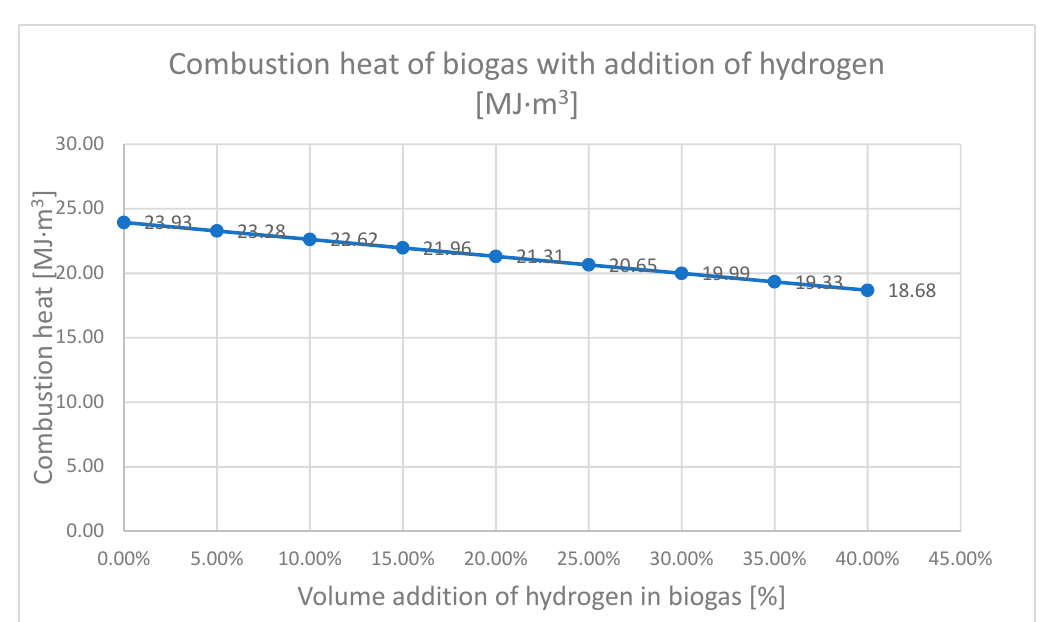
Figure 6. Change in the heat of combustion of the mixture of biogas and hydrogen with a higher volume content of hydrogen.